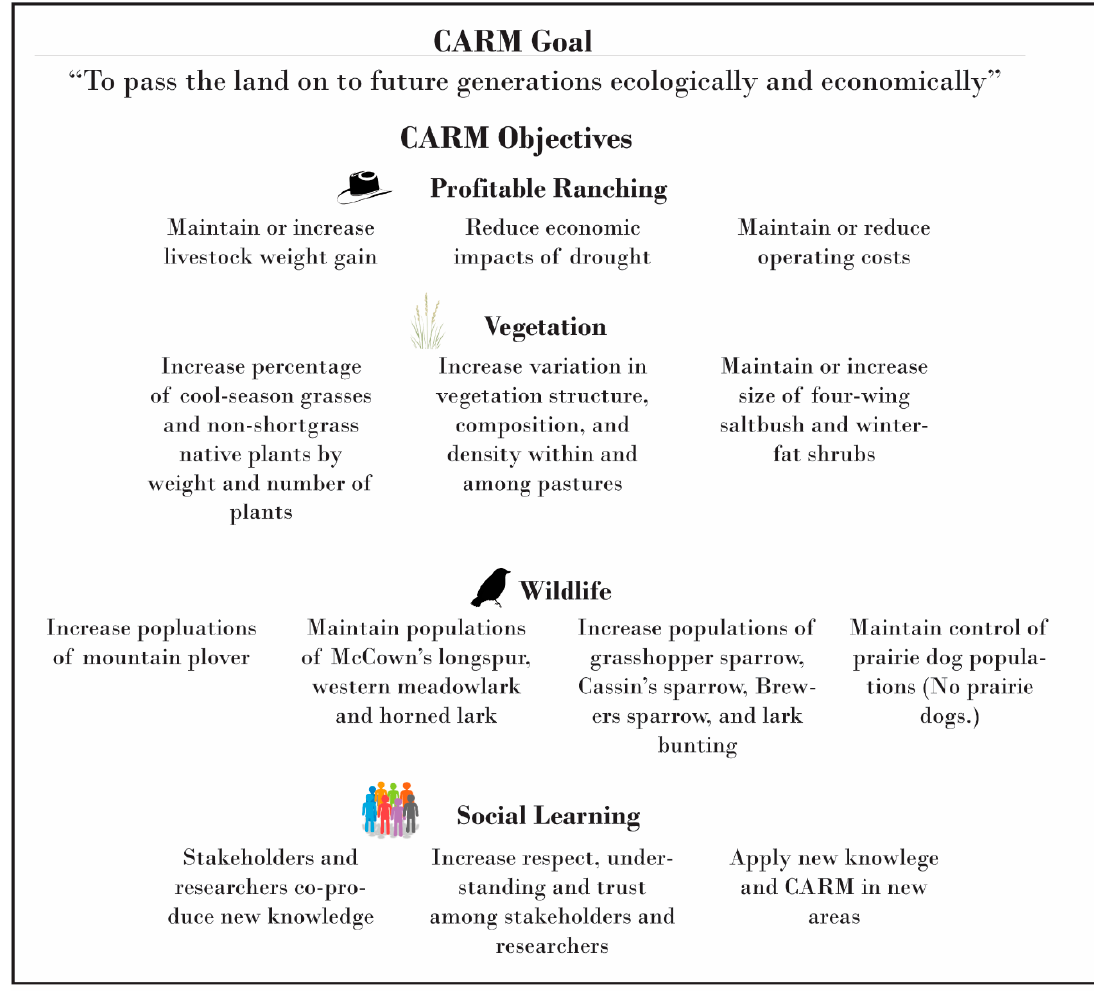
Figure 3. The CARM project goals and profitable ranching, vegetation, and wildlife management objectives were established in 2012. Social learning objectives were added in 2016.